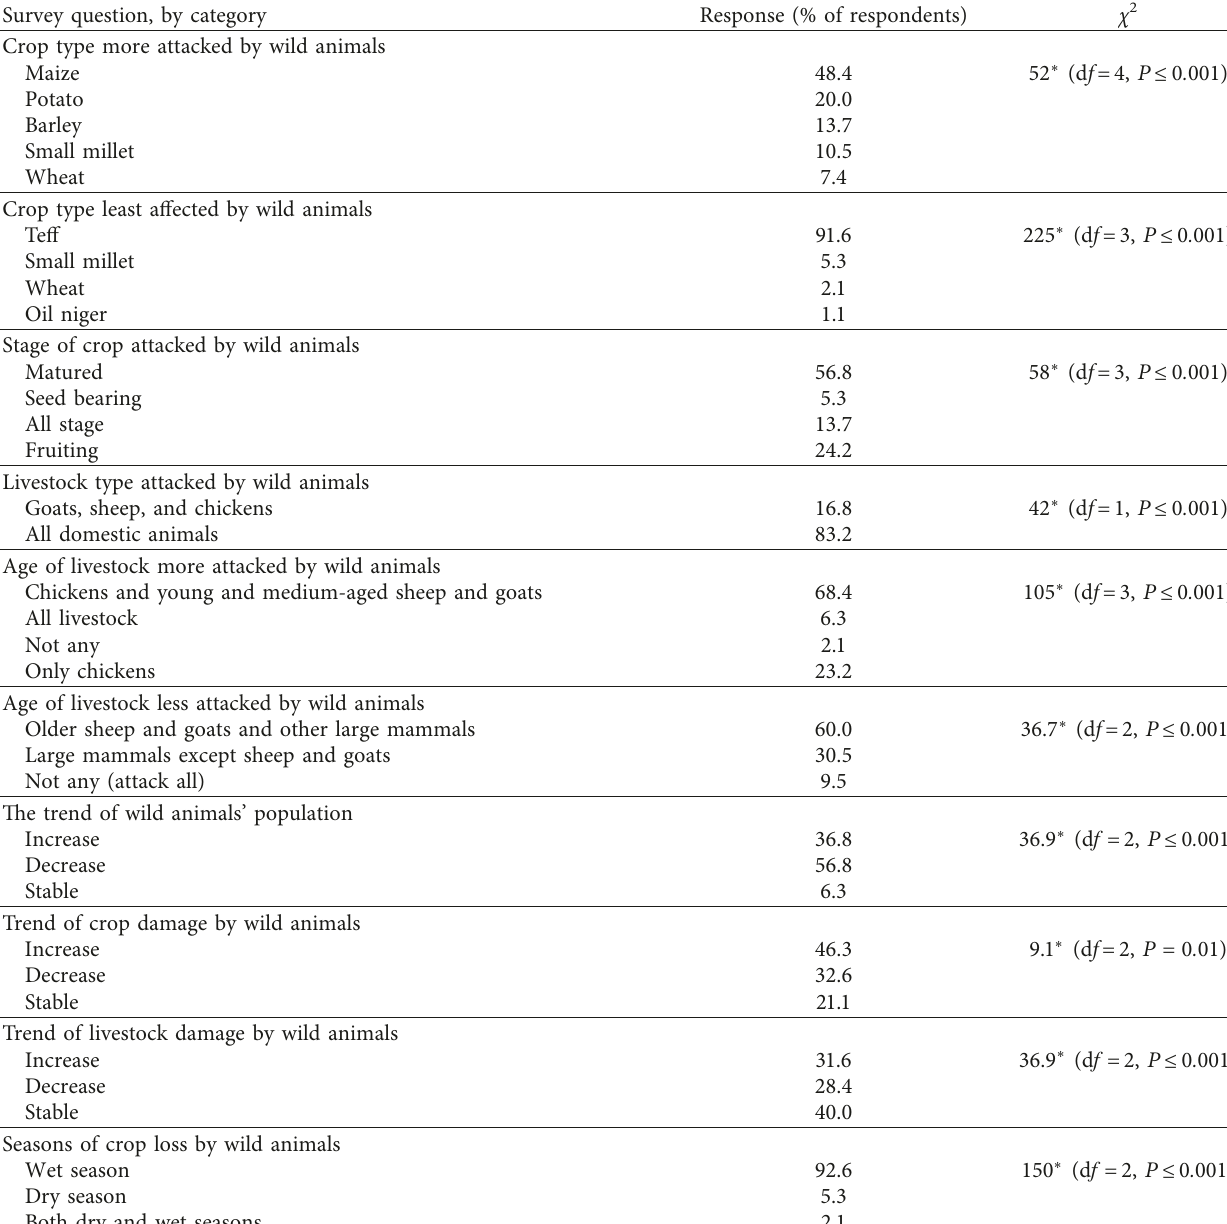
Table 4: The status of crop-raiding risk among crop types, stage of crops attacked by wild animals, type of animals attacked by wild animals, the age of livestock more or less attacked by wild animal, the trend of the wild animals’ population and crop and livestock damage, the season of crop and livestock damage by wild animals, causes of human-wild animal conflict, types of problem faced by wild animals, and human- wild animal conflict management mechanisms of the respondents in the study area.